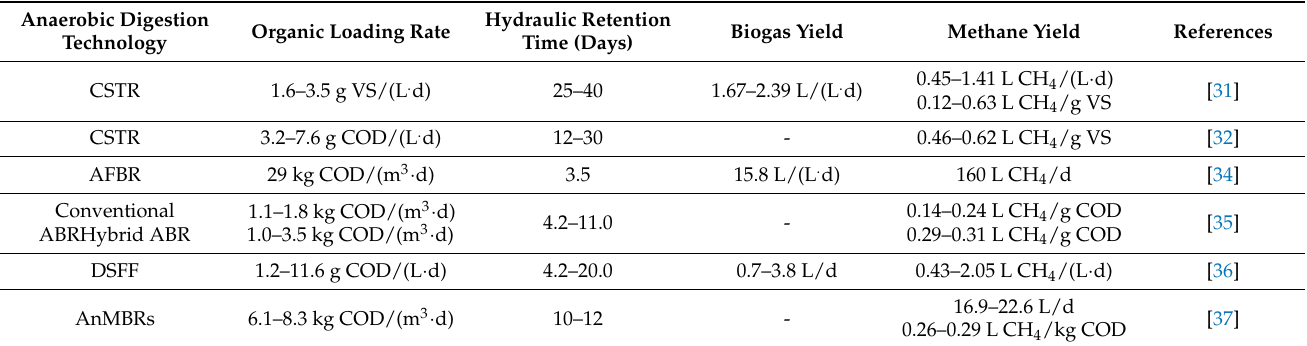
Table 2. Technologies of anaerobic digestion of distillery